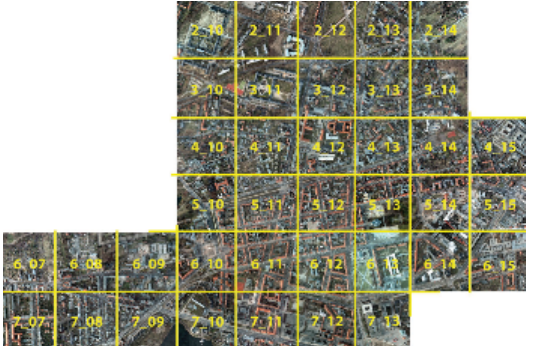
Figure 10. Outlines of all patches overlaid with TOP mosaic of Potsdam